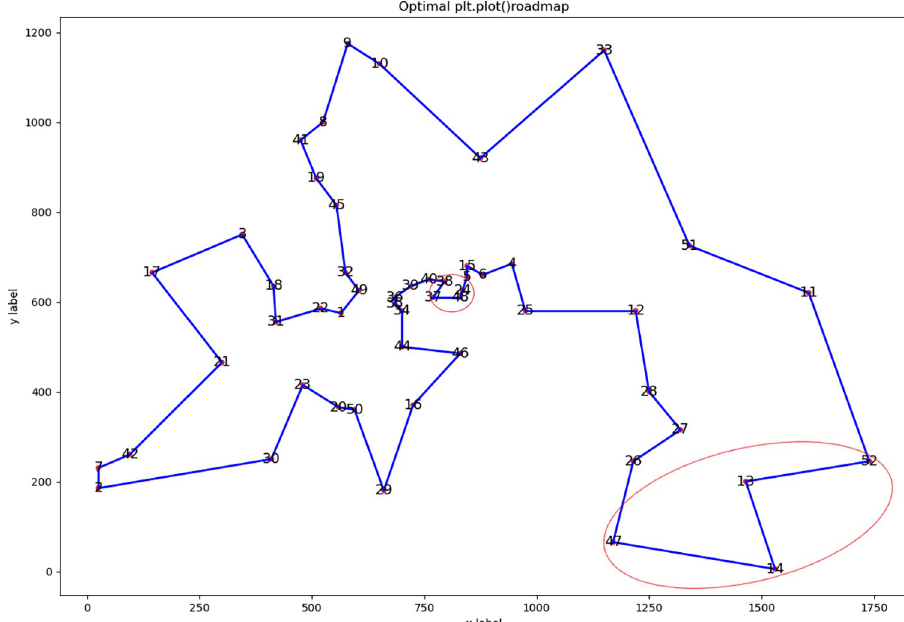
Fig 3. The optimal route of Berlin52 output by ABSQL algorithm.